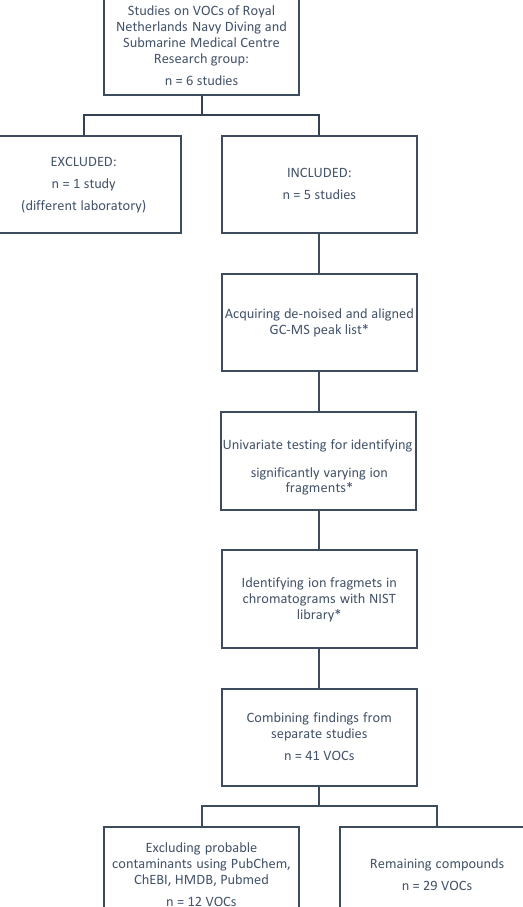
Figure 1. An overview of data acquisition, statistical analysis, and compound selection. * Procedures marked with an asterisk were performed for each study separately.